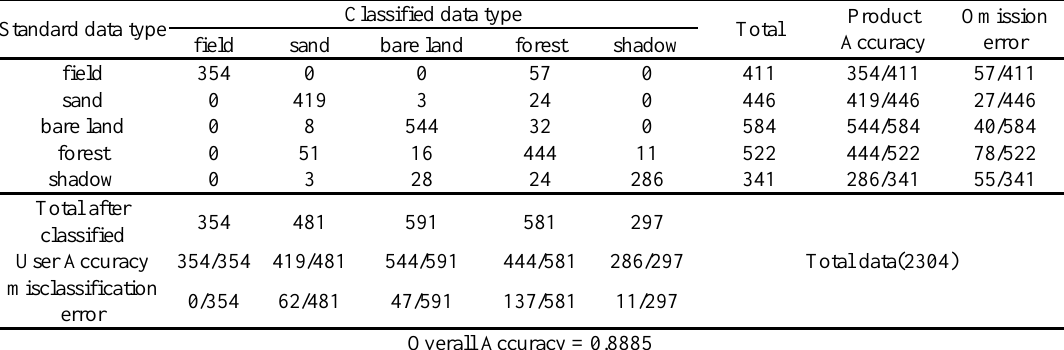
Table 2. Error matrix of ECOC SVMs classification